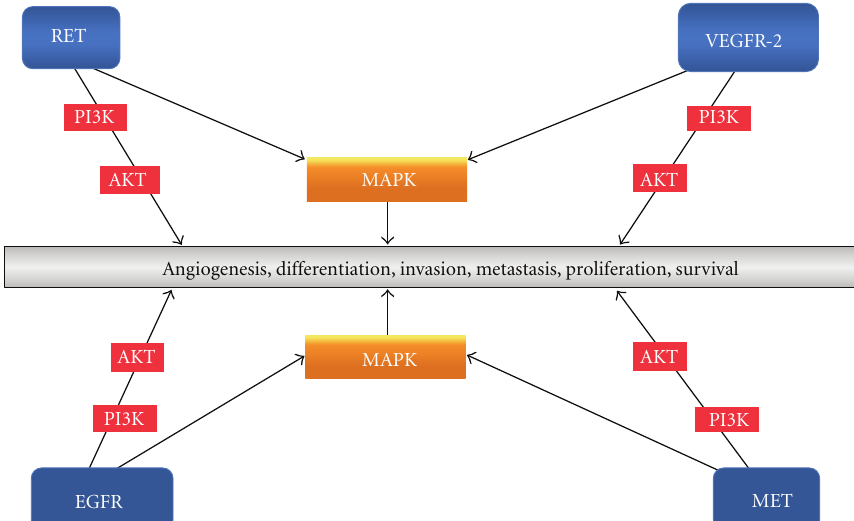
Figure 2: Simplified schematic representation of some of the TKs and pathways involved in MTC carcinogenesis as well normal physiology. These TKs represent important targets of TKIs. Written in the gray box are the consequences of the activation of multiple pathways and not of any one in